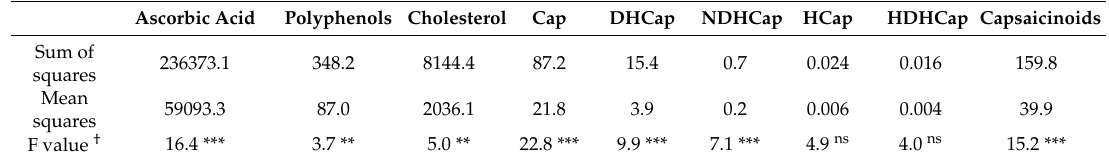
Table 1. Analysis of variance for biochemical traits among the five Capsicum species. Cap = Capsaicin, DHCap = Dihydrocapsaicin, NDHCap = Nordihydrocapsaicin, HCap = Homocapsaicin, HDHCap = Homodihydrocapsaicin.